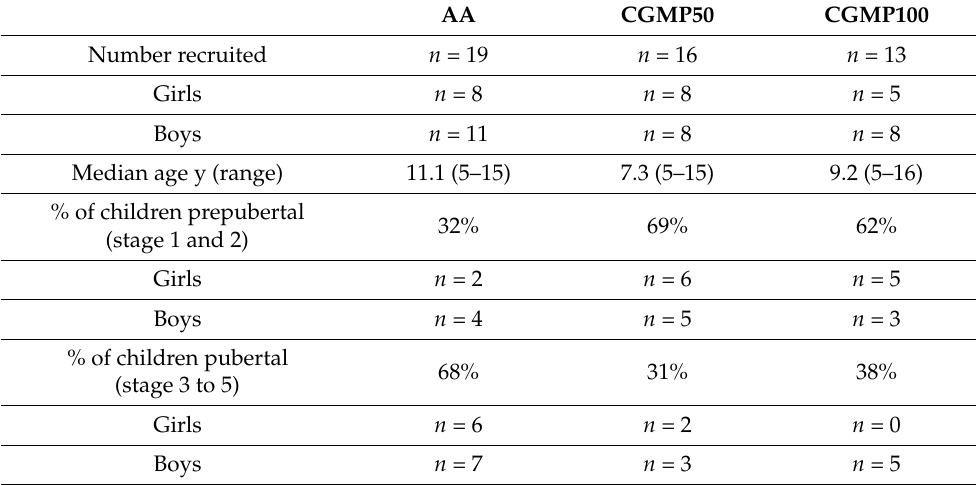
Table 1. Subject characteristics at